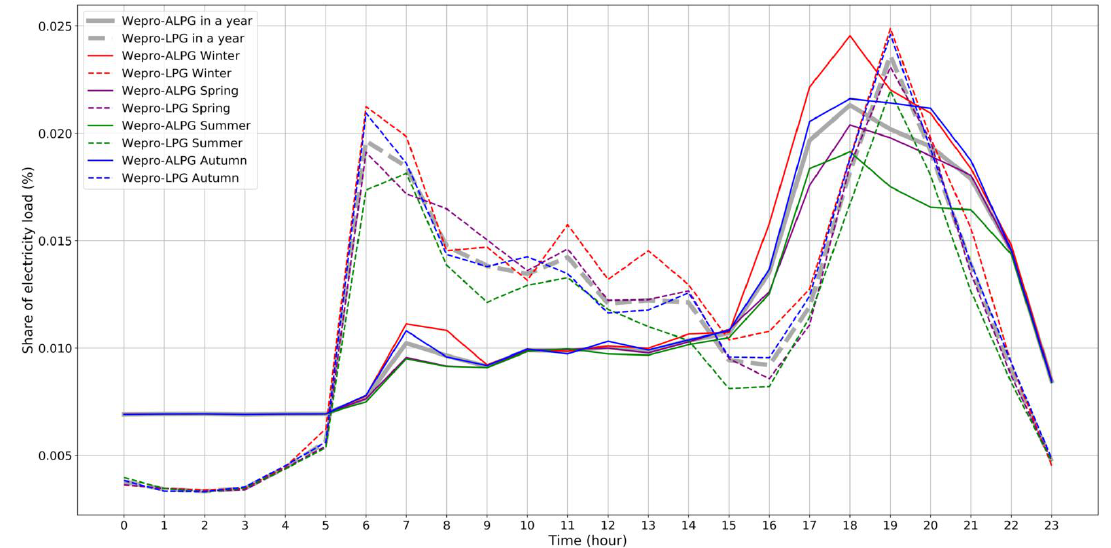
Figure 13. The hourly average load share in a year and the hourly average load share in each season based on the results of Wepro-LPG and Wepro-ALPG models.